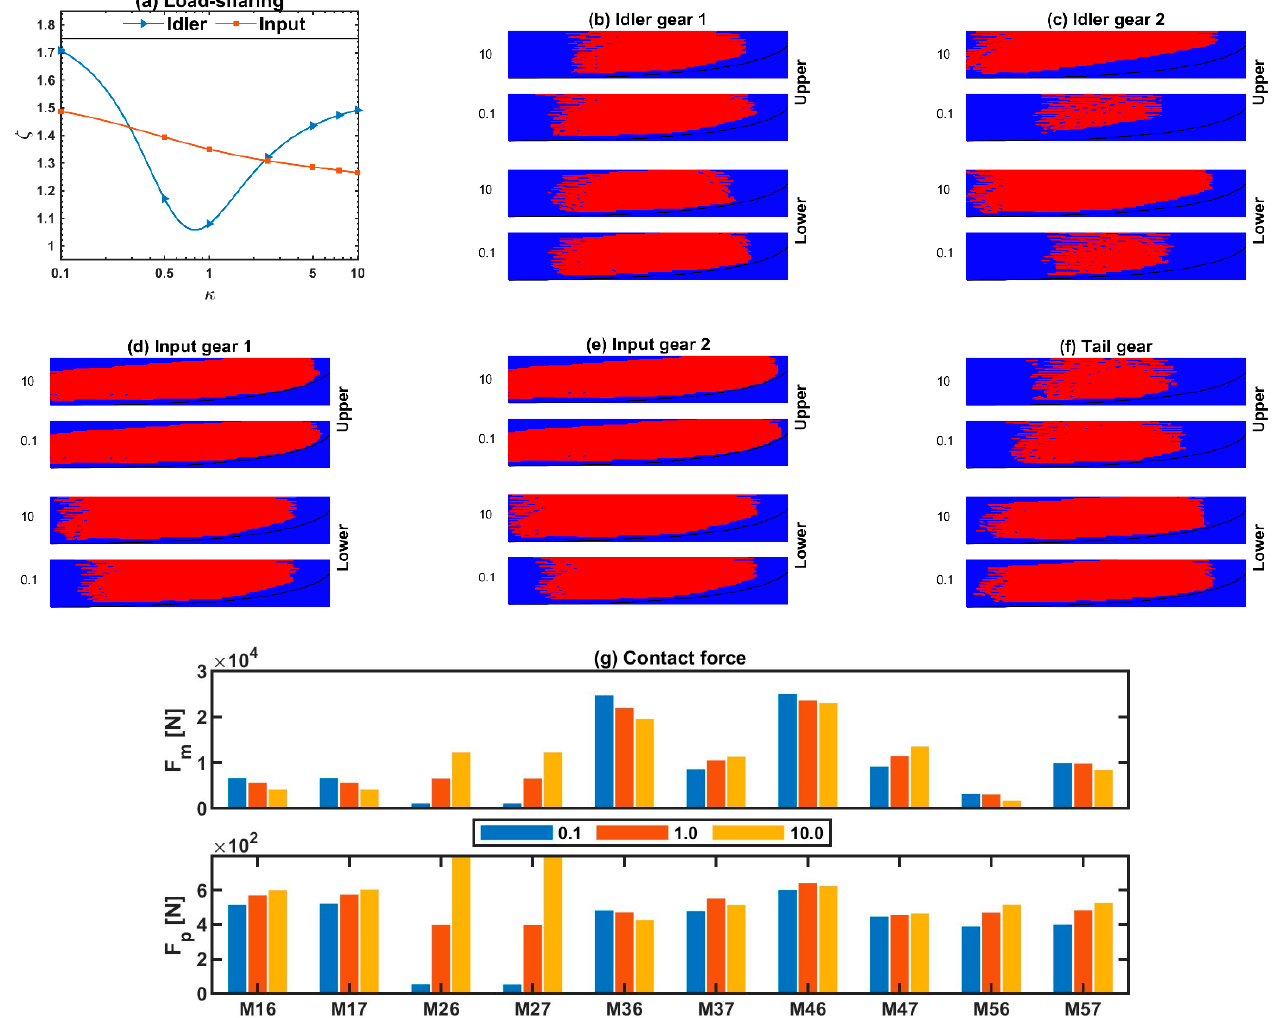
Figure 12. Influence of the support stiffness of the lower face gear on the load-sharing and contact characteristics.